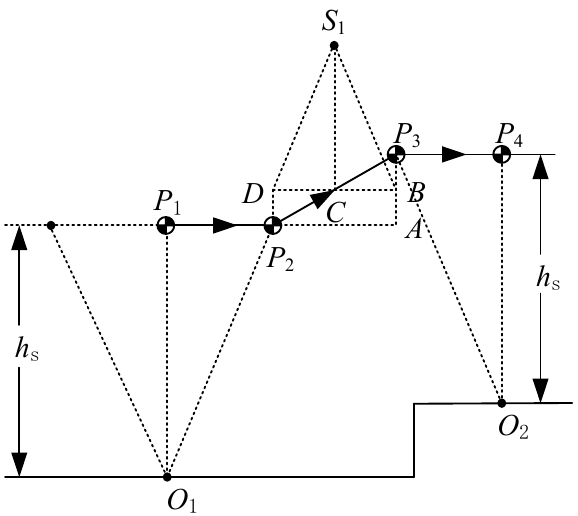
Figure 12. Realtime trajectory planning for terrain-blind walking.